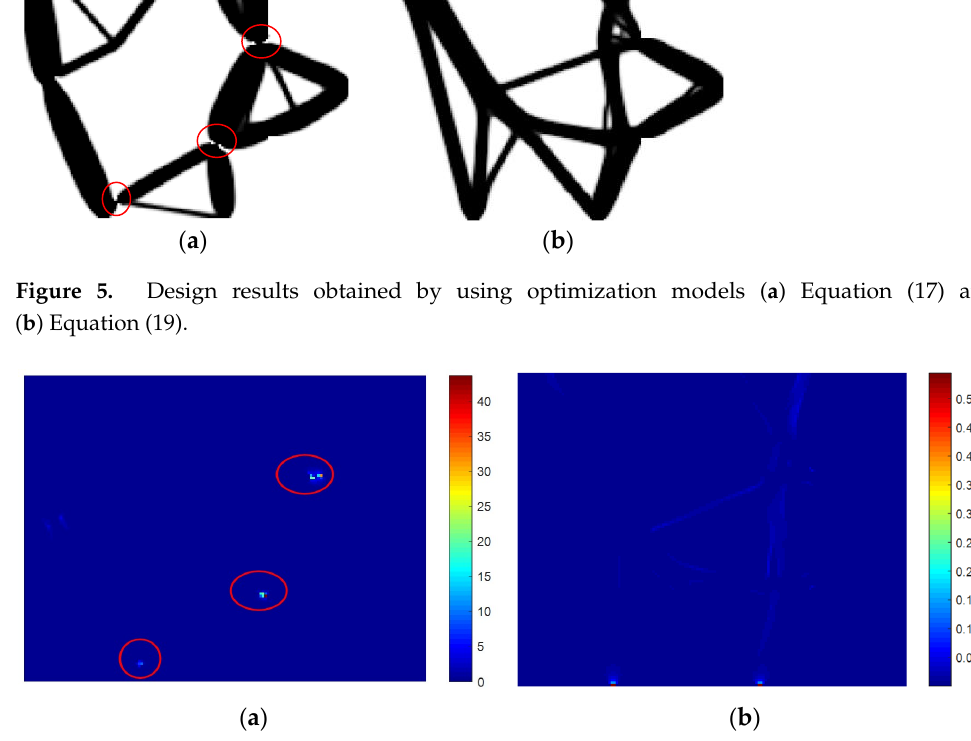
Figure 6. Plots of the resulting strain energy densities related to optimization modes ( a ) Equation (17) and ( b ) Equation (19).